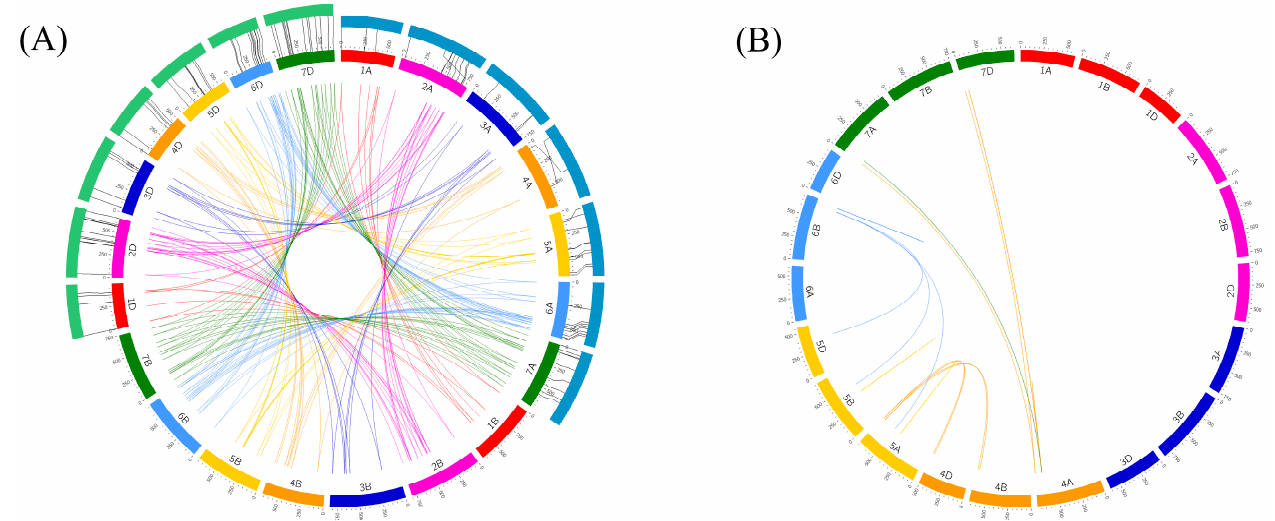
Figure 5. Synteny analysis and gene duplication of wheat U-box E3 genes using the BLASTP algorithm. ( A ) An E-value < 1e − 10 , minimum sequence identity > 90%, and bitscore > 500 were used to create a synteny map among wheat, T. urartu, and A. tauschii . The green annulus on the top left represents chromosomes of A. tauschii , and the blue annulus on the top right represents chromosomes of T. urartu . Homoeologous genes in each chromosome of wheat are linked by lines with identical color. ( B ) Duplicated U-box E3 gene pairs identified in wheat with the alignment covered >80% of the longer gene and the identity the aligned region > 90%. Duplicated gene pairs are depicted in corresponding colors and linked using lines with the corresponding color.